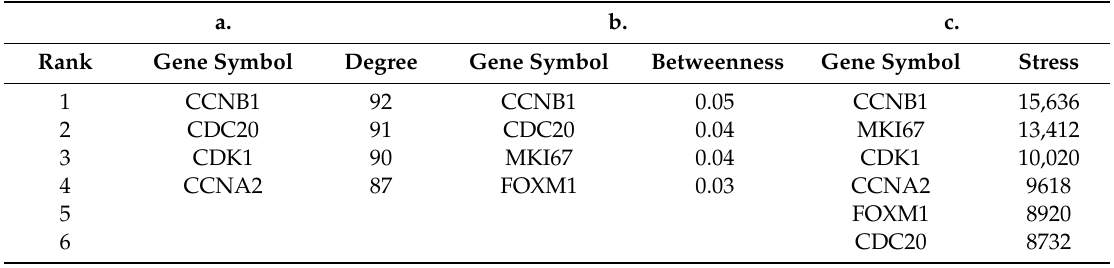
Table 2. Top communicative genes (module 1) ranked based on a. degree, b. betweenness, c. stress. a. b.